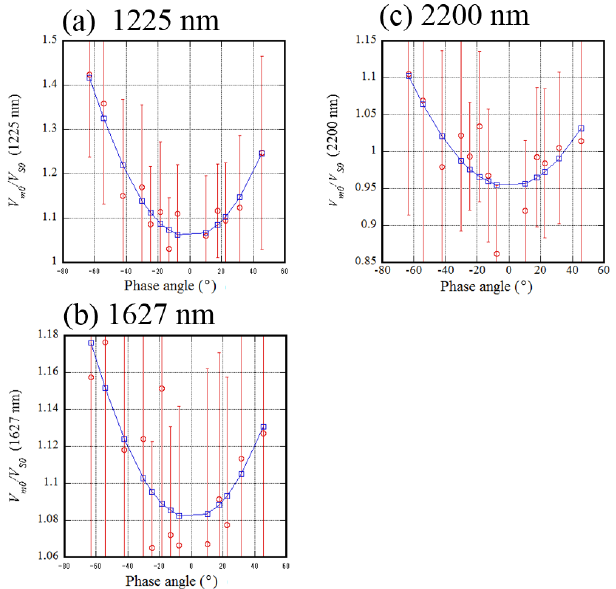
Figure 6. Relationship between phase angle and reflectance correc- tion factor C = V m 0 /V S 0 in the shortwave infrared region. A re- gression curve ( C = A c · g 2 + B c , g : phase angle) was also